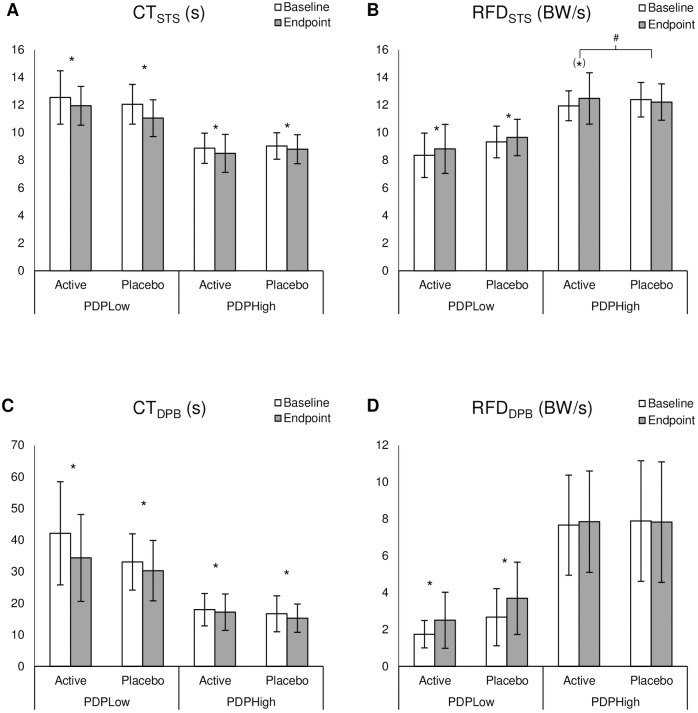
Results for subgroups.A Completion time of the sit-to-stand task (CTSTS), B rate of force development of the sit-to-stand task (RFDSTS), C completion time of the dynamic postural balance task (CTDPB), and D rate of force development of the dynamic postural balance task (RFDDPB) for low-performers (PDPLow) and high-performers (PDPHigh) of the persons with Parkinson’s disease receiving active or placebo transcranial pulsed electromagnetic fields. Bodyweight (BW). Data presented as the mean ± SD. * P≤0.05 for main effect of time. (*) 0.05 < P < 0.1 for the main effect of time. # P≤0.05 for the group×time interaction effect.